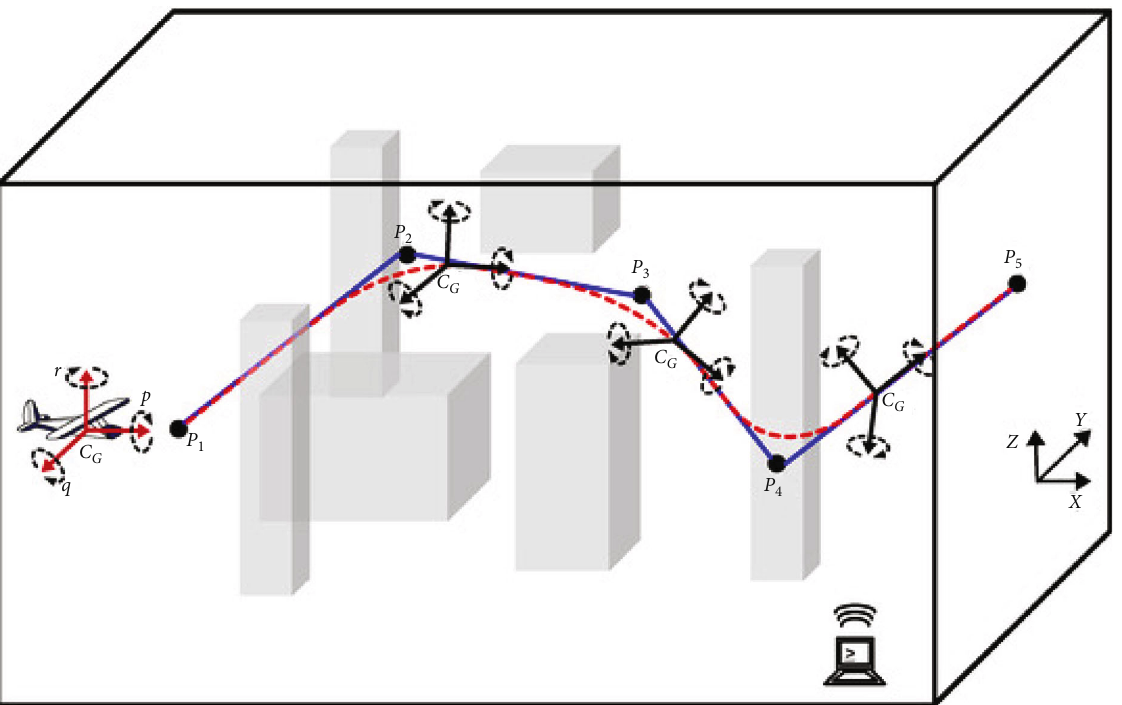
Figure 2: The collision-free point set Pi is represented by black dots; the blue line describes the discrete path constructed according to the 3D path plan; the red dashed line is the new smooth and optimized path that the UAV can follow